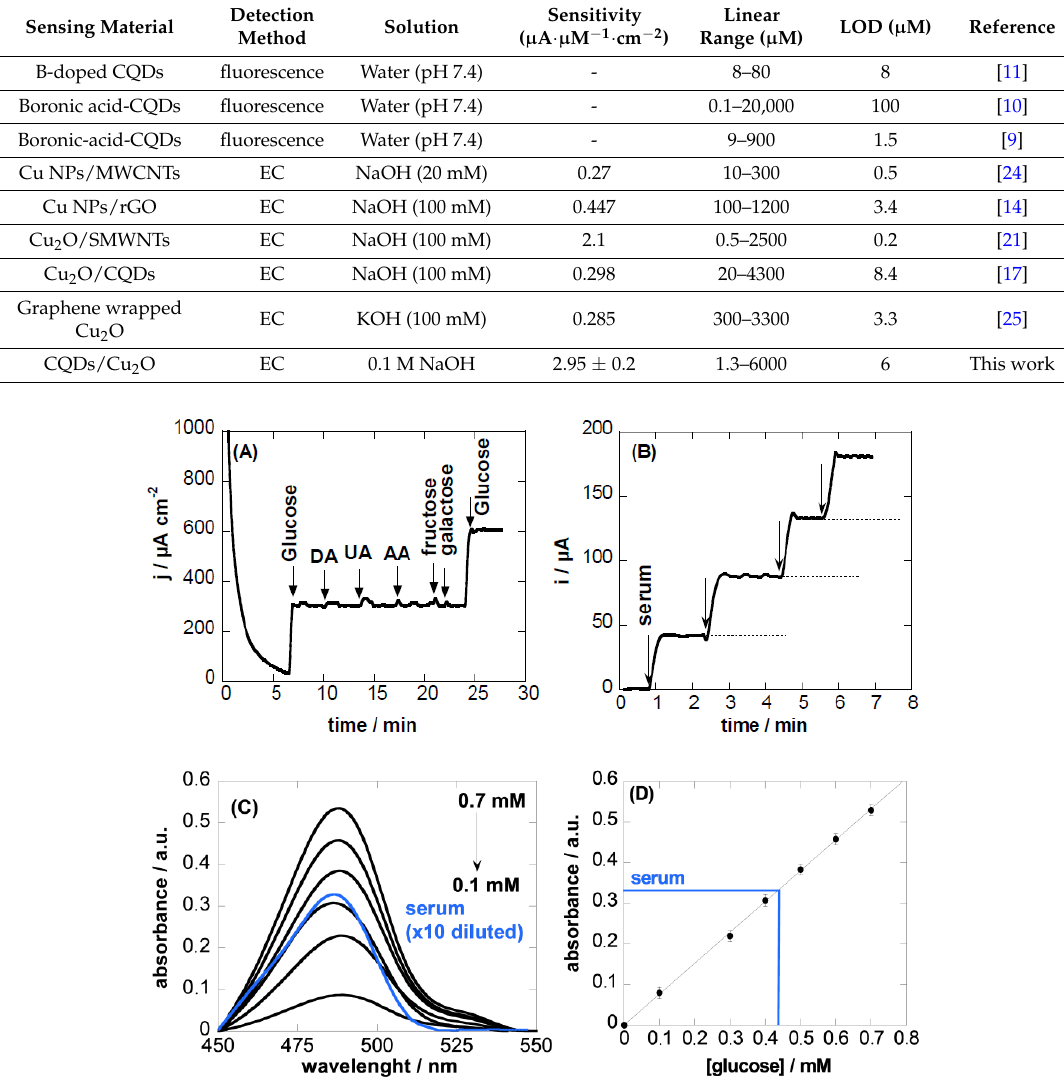
Figure 5. ( A ) Interference test of CQDs/Cu 2 O-modified GCE electrode in 0.1 M NaOH at +0.55 V with 100 µ M glucose in the presence 500 µ M dopamine (DA), uric acid (UA), ascorbic acid (AA),